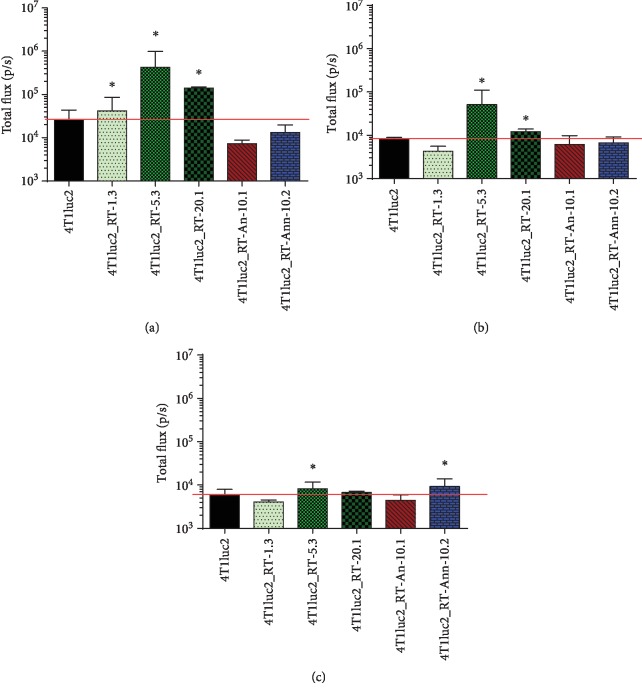
Localization of luciferase-expressing cells in the organs of mice implanted with 4Tluc2 and derivative clones expressing variants of HIV-1 FSU_A reverse transcriptase (RT_A) after ectopic implantation into BALB/c mice as assessed by ex vivo bioluminescent imaging of the lungs (a), liver (b), and spleen (c). The values represent the mean total flux (p/s) ± SD (n = 3). ∗Significant difference from the value exhibited by the respective organ in 4Tluc2-implanted mice (p < 0.05; Mann-Whitney test).